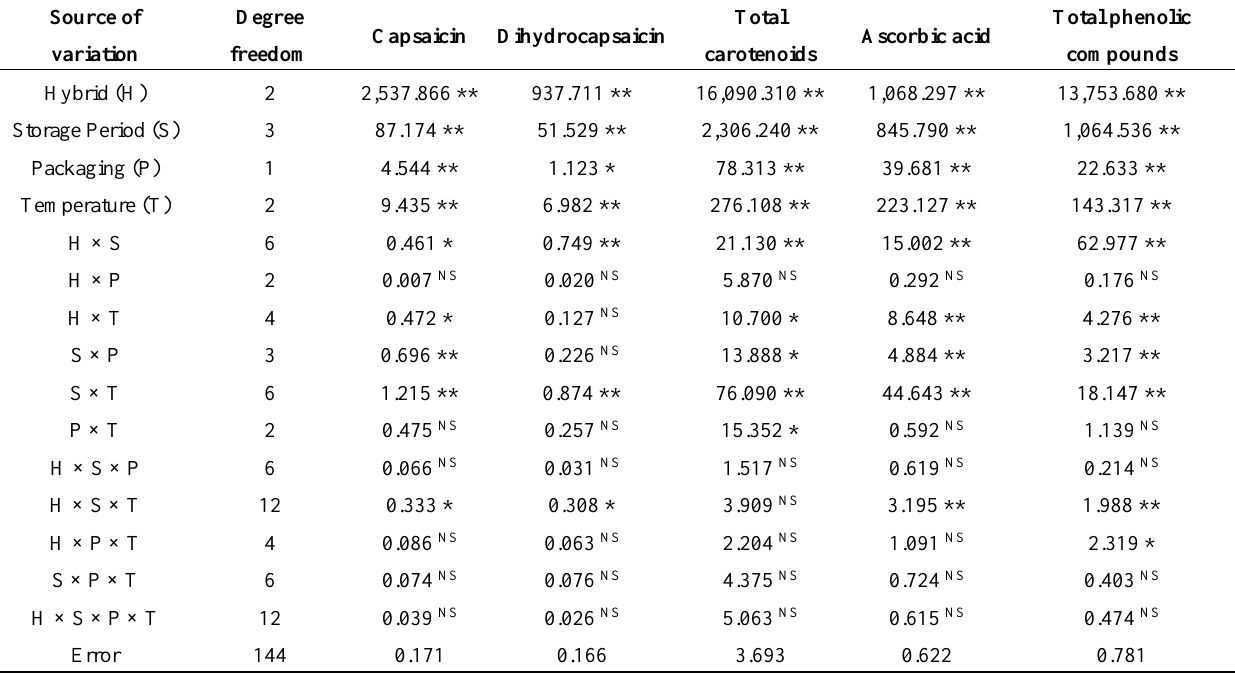
Table 1. Mean square values from the analysis of variance for capsaicin, dihydrocapsaicin, total carotenoids, ascorbic acid and total phenolic contents (mg/100 g) of hot pepper hybrids under different packaging and storage conditions.